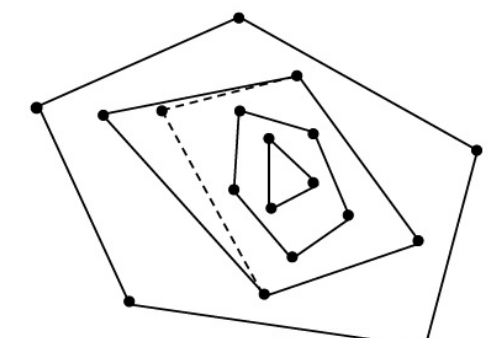
Figure 10: Least inner layer expands.